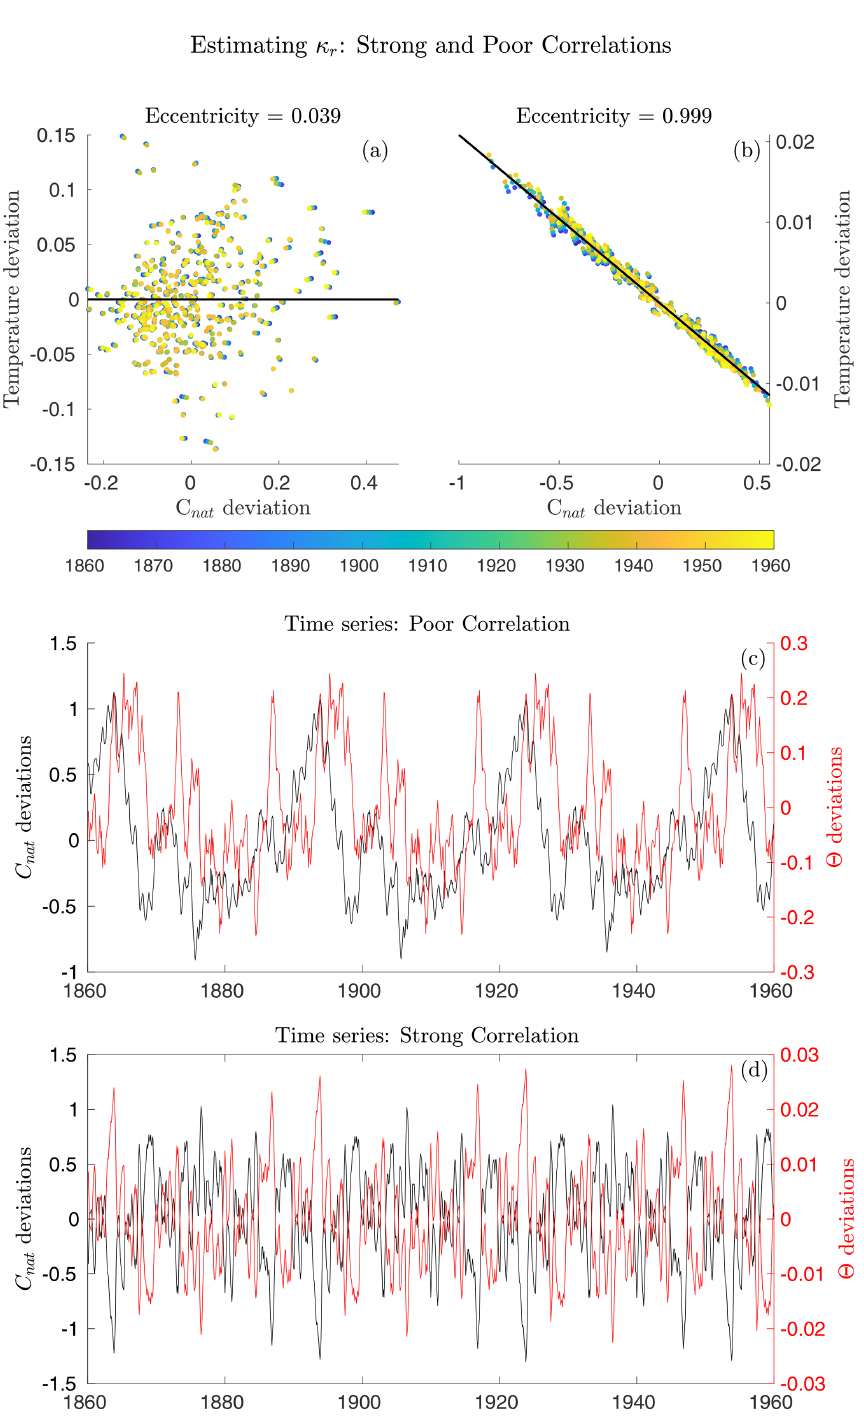
Figure A1. The correlations between C nat and θ used to establish a κ r value for a poorly correlated point (a and c) and a well-correlated point (b and d) in θ − C nat space (a and b) and time series of both (c and d) . These two points are located at 24 ◦ N, 30 ◦ W in the Atlantic at depths of 850 and 1950m. The major axis of the covariance ellipse in panels (a) and (b) is shown in black.